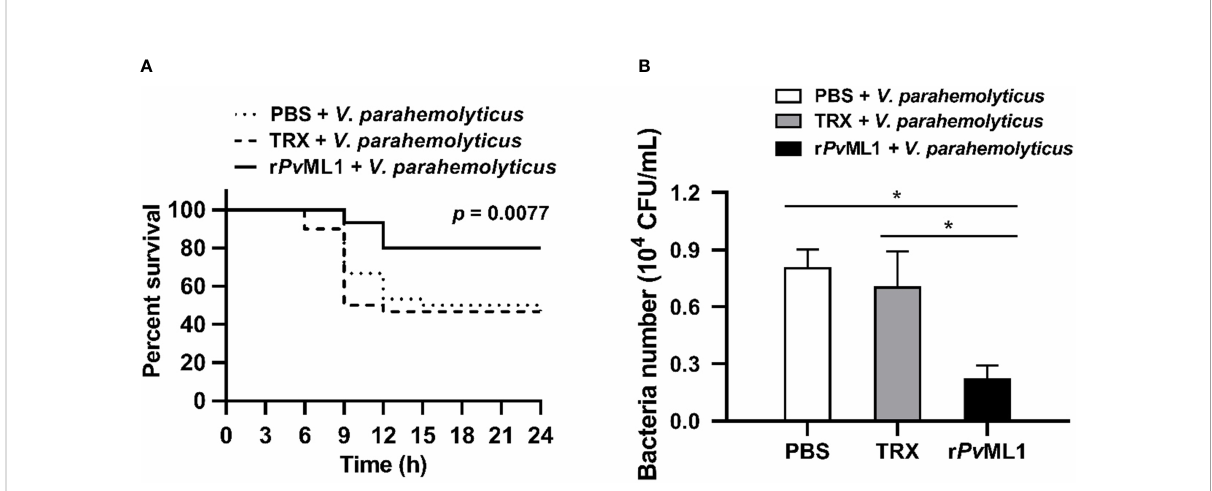
FIGURE 4 Protective role of Pv ML1 against bacterial infection and its effect on bacterial clearance in hemolymph. (A) V. parahemolyticus pre-incubated with r Pv ML1 was injected into shrimp to calculate the survival rates. Thirty shrimp were used for each group, and the results were analyzed by Log-rank (Mantel-Cox) test. (B) The ability to clear V. parahemolyticus in hemolymph was increased by the “ overexpression ” of Pv ML1 protein. TRX served as negative control, PBS was used as blank control (* P <